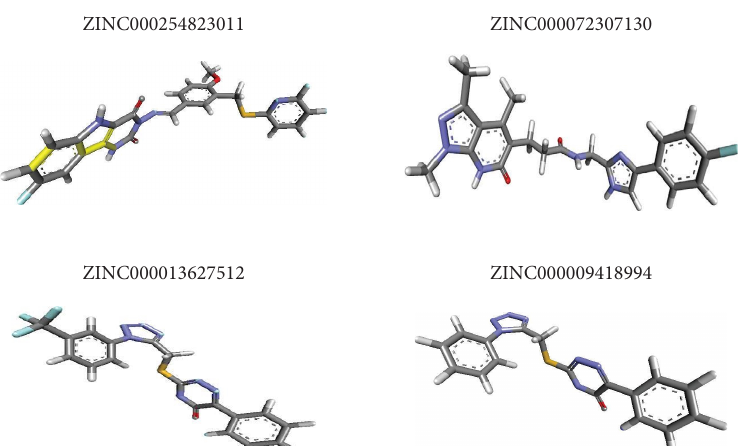
Figure 3: *e 3D structure of prepared SARS-CoV-2 M pro . All the water molecules and other heteroatoms have been removed from SARS- COV-2 M pro retrieved from PDB, ID 6Y2E. *e three domains (I, II, and III) are indicated.